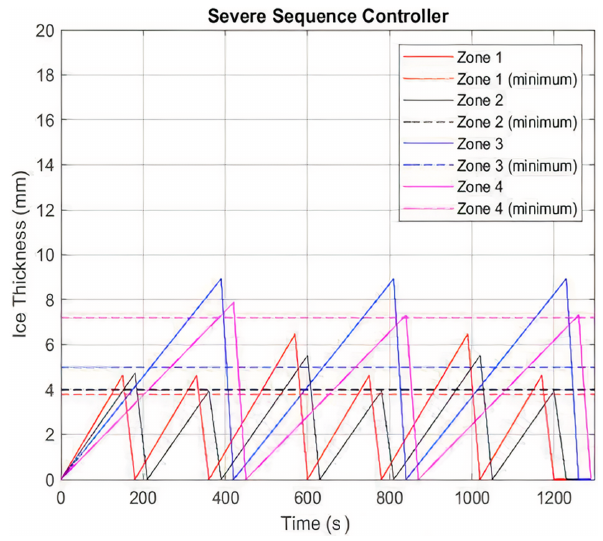
Figure 29. Repeatable time sequence for severe icing conditions.